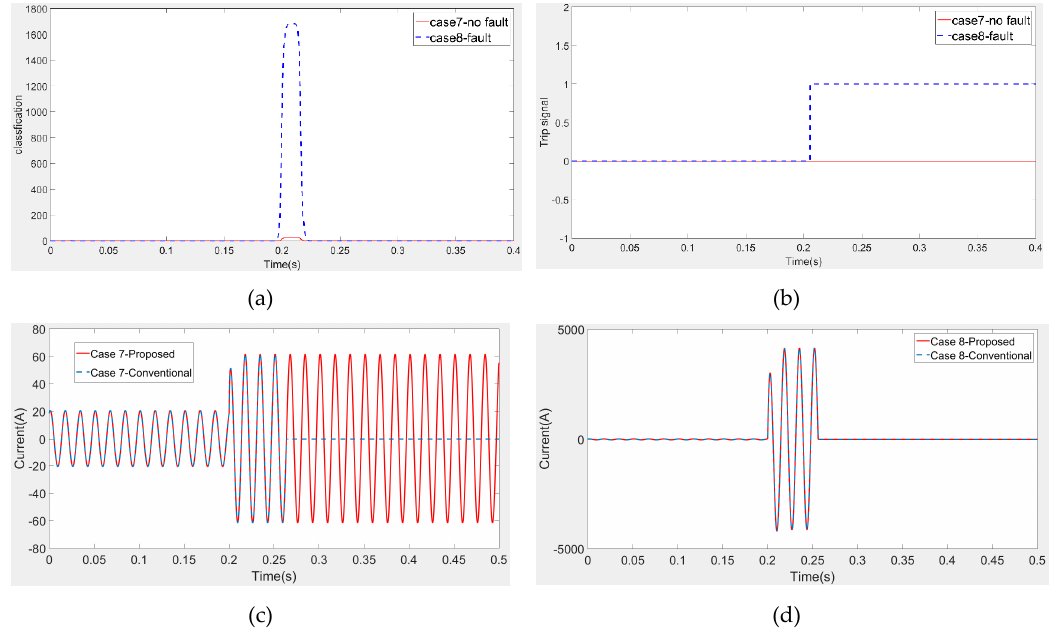
Figure 20. Simulation results of case 7 and 8. (a) Calculation result of classification value; (b) Trip signal; (c) Current flowing in the Y line in case 7; (d) Current flowing in the Y line in case 8.